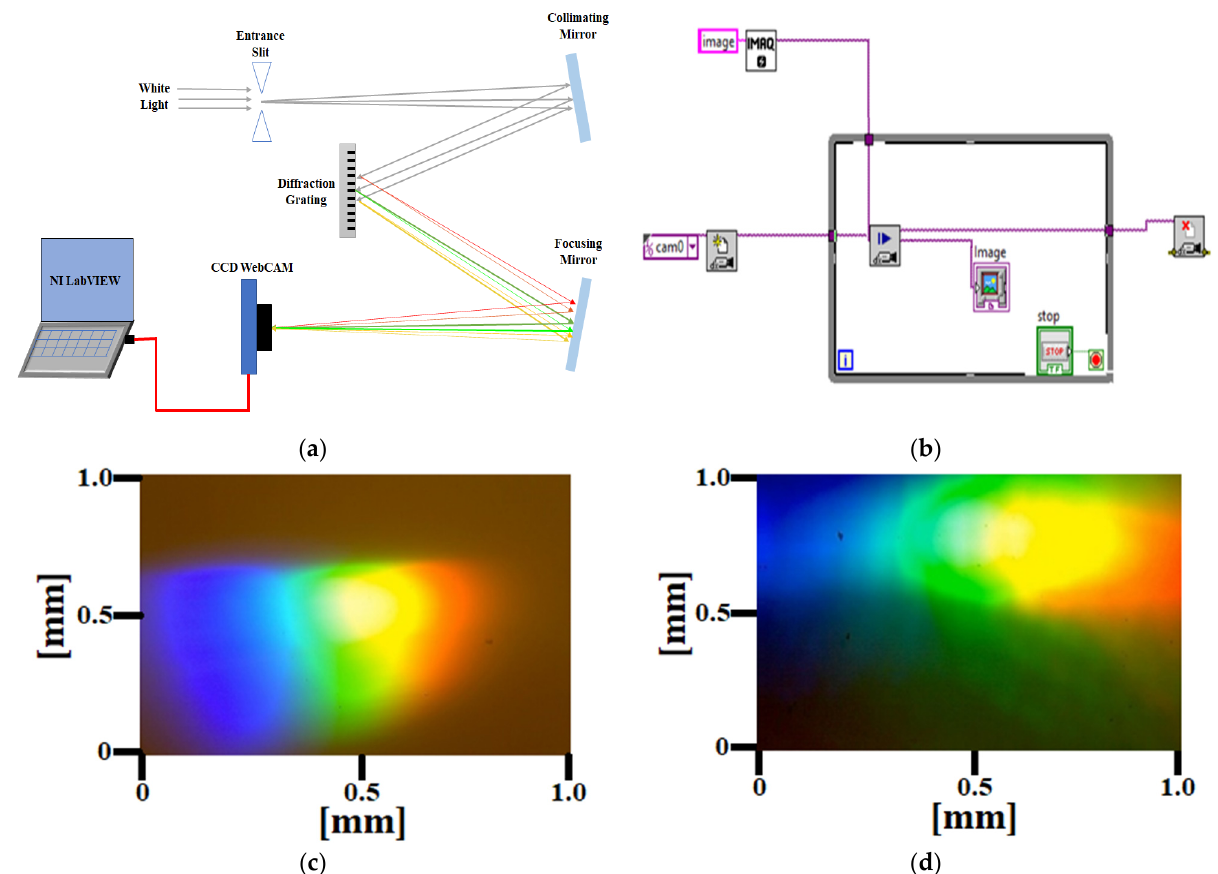
Figure 3. ( a ) Schematic of the experimental setup of the Czerny–Turner configuration-based optical spectrometer. ( b ) Block diagram in LabVIEW for image acquisition in snaps. ( c ) Image of spectrum acquired using NI LabVIEW program for a prism as dispersive element. ( d ) Image of spectrum acquired using NI LabVIEW program for diffraction grating as a dispersive element.